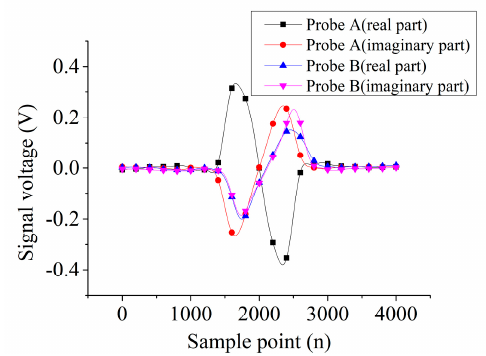
Figure 5. The real and imaginary part signal for infinite defect.